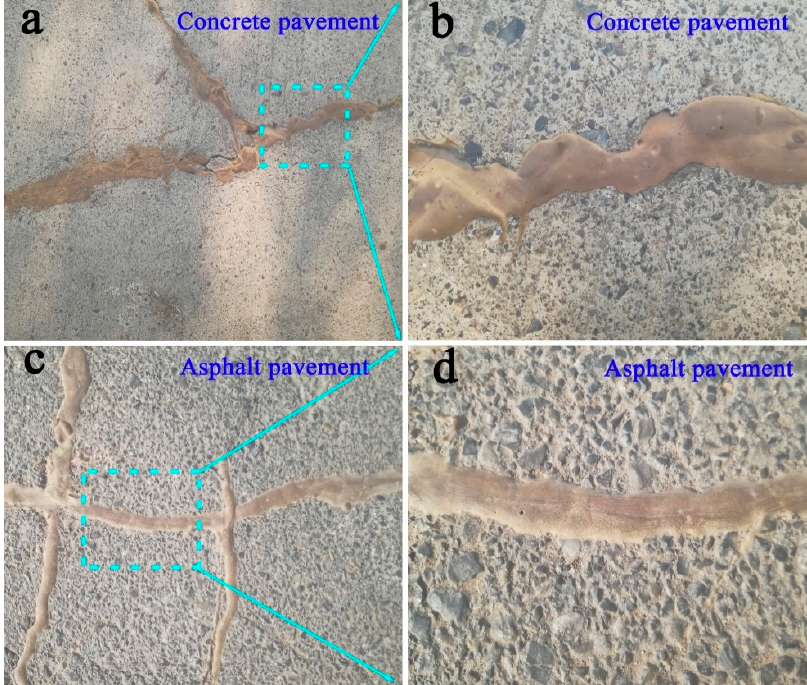
Figure 6. Combustion progress of polyurethane ( a ) and PRC ( b ) in air.